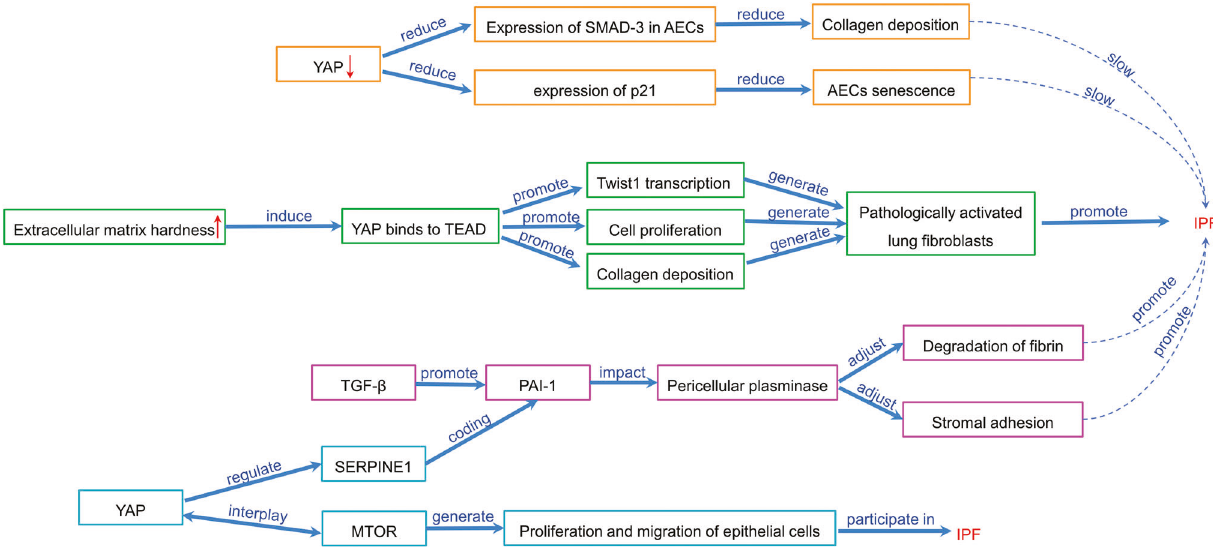
Fig. 5 The role of hippo signaling pathway in IPF. When the stiffness of the extracellular matrix increases, YAP enters the nucleus and binds with TEAD to promote Twist1 gene transcription, cell proliferation, and collagen deposition, thus causing pulmonary fi brosis. Meanwhile, TGF- β promotes the expression of PAI-1, which regulates the degradation of fi brin and stromal adhesion of lung fi broblasts by affecting the activity of pericellular plasminase. The Serpine1 gene which encodes PAI-1 is regulated by YAP. In addition, YAP knockout reduces the expression of Smad-3 and p21 in AECs, and reduces collagen deposition and aging AECs, thus slowing down the IPF. YAP can also interact with the mTOR signaling pathway to regulate the abnormal proliferation, polarity and migration of respiratory epithelial cells, and participate in the pathogenesis of IPF. Note: IPF idiopathic pulmonary fi brosis, TEAD TEA domain family, TNF tumor necrosis factor, AECs alveolar epithelial cells, PAI-1 plasminogen activator inhibitor-1, TGF- β transforming growth factor- β , Serpine1 serine protease inhibitor clade E member